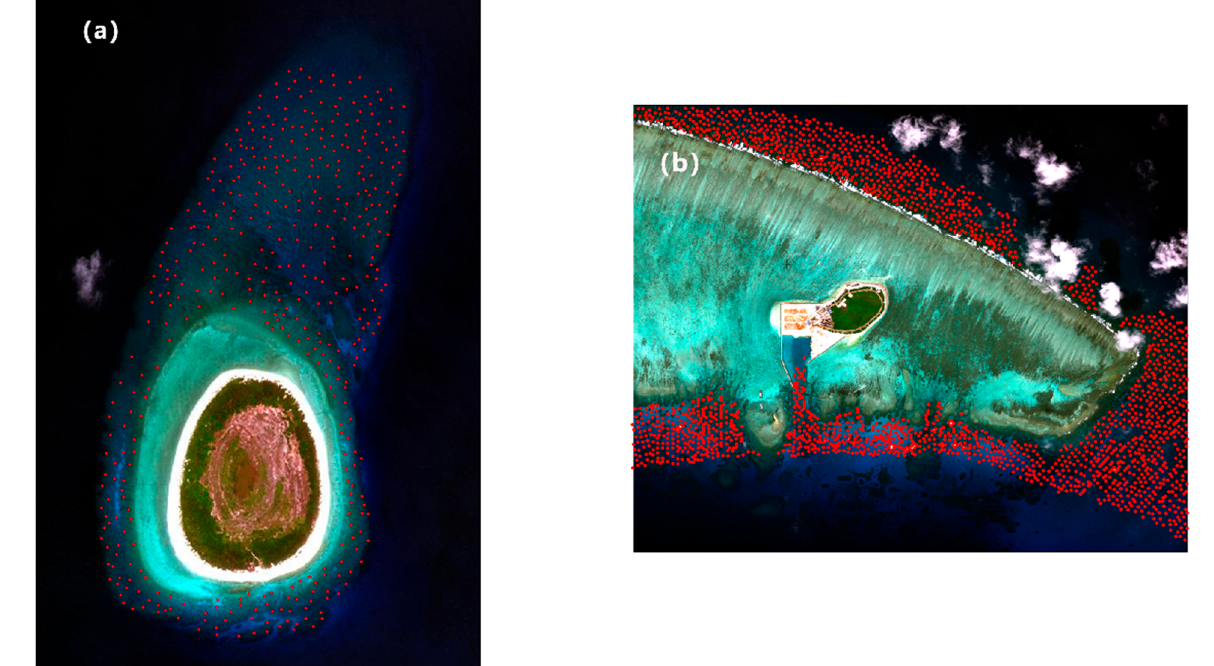
Figure 4. Distribution of in-situ depth data in ( a ) Ganquan Island and ( b ) Zhaoshu Island.